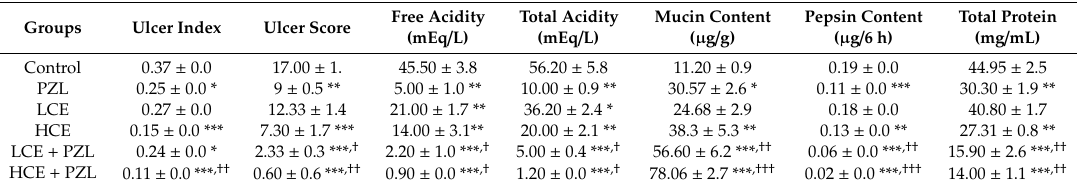
Table 3. Impact on gastric histological profile in pylorus ligated rats.